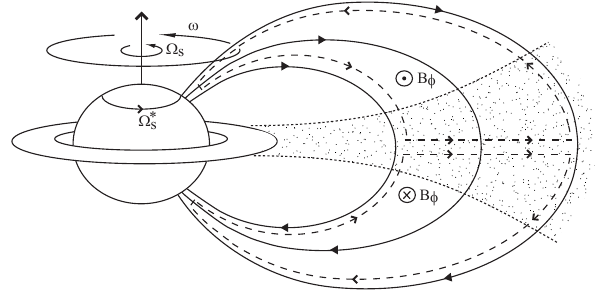
Fig. 1. Sketch of a meridian cross section through Saturn’s quasi- axisymmetric inner and middle magnetosphere, extending to dis- tances of ∼ 15–20 R S in the equatorial plane. The arrowed solid lines indicate magnetic field lines, which are modestly distended outward from the planet by azimuthal currents (the ‘ring-current’) flowing in the near-equatorial plasma. The rotating plasma is shown by the dotted region, consisting mainly of protons and oxygen ions and associated electrons, which derive from water ice originating from ring grains and moon surfaces. Three angular velocities are indicated. These are the angular velocity of a particular shell of field lines ω , the angular velocity of the planet (cid:127) S , and the angu- lar velocity of the neutral upper atmosphere in the Pedersen layer of the ionosphere, (cid:127) ∗ . The value of (cid:127) ∗ is expected to lie between S S ω and (cid:127) S because of the frictional torque on the atmosphere due to ion-neutral collisions. The oppositely-directed frictional torque on the magnetospheric flux tubes is communicated to the equato- rial plasma by the current system indicated by the arrowed dashed lines, shown here for the case of sub-corotation of the plasma (i.e. ω < (cid:127) S ). This current system bends the field lines out of meridian planes into a ‘lagging’ configuration, associated with the azimuthal field components B ϕ